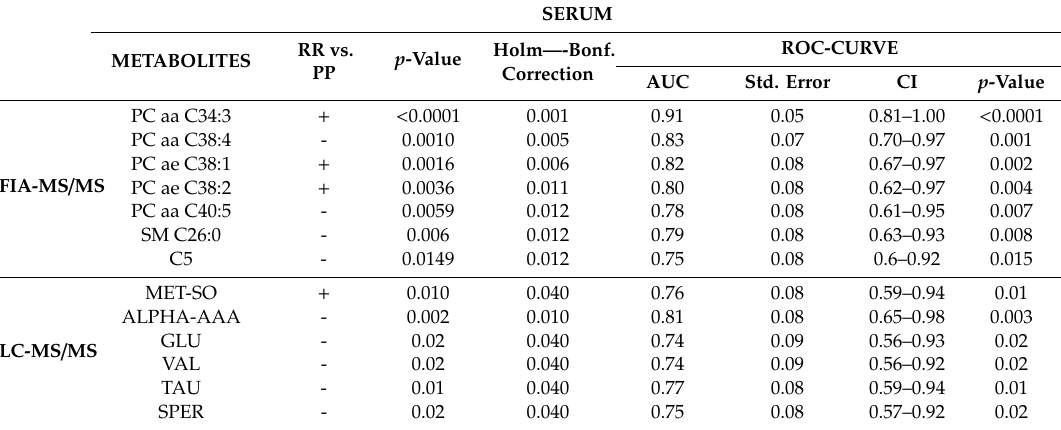
Table 4. Trend, univariate analysis, and ROC curve analysis of the discriminant metabolites in serum samples